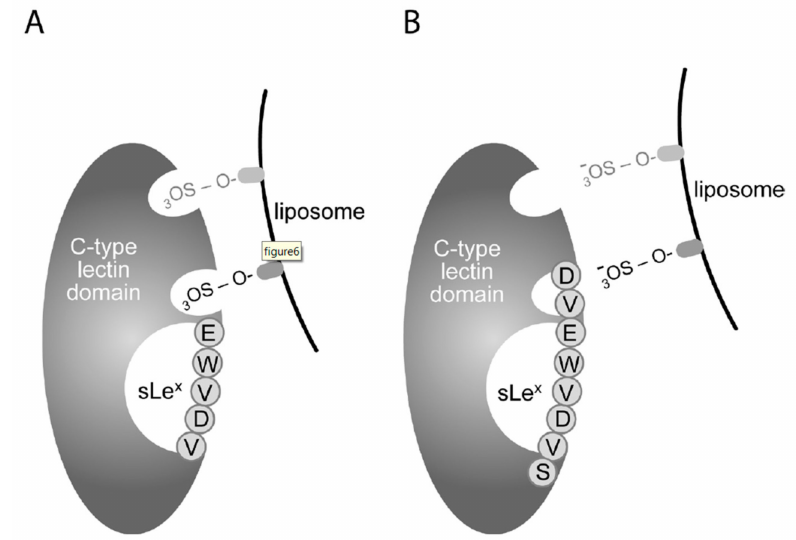
Figure 6. Model of sulfatide binding to P-selectin. A sulfatide moiety in liposome Sf28 docks into one of the defined sulfotyrosine binding sites on P-selectin [40–42]. ( A ) Peptide antagonist EWVDV binds to the sLe x binding pocket but does not inhibit the interaction of sulfatides with P-selectin. ( B ) Sulfatide binding is inhibited by elongated peptide antagonist DVEWVDVS, which interacts with the sLe x binding pocket, and may protrude at its N-terminal end into the sulfatide binding pocket. The N-terminal, negatively charged, aspartic acid is probably involved in the interaction with positively charged lysine residues at positions 111 and 113 in P-selectin that mediate interaction with sulfatides [19,28]. The sulfatide moiety indicated in dark grey docks into the Ca 2 + -dependent binding site, while at high-density, a second or even third sulfatide moiety, indicated in light grey, interacts with Ca 2 + -independent binding pockets. The Ca 2 + -dependent interaction of sulfatides with P-selectin is blocked by WAPS12.2, AK-4, and elongated peptides, while the Ca 2 + -independent binding is exclusively blocked by